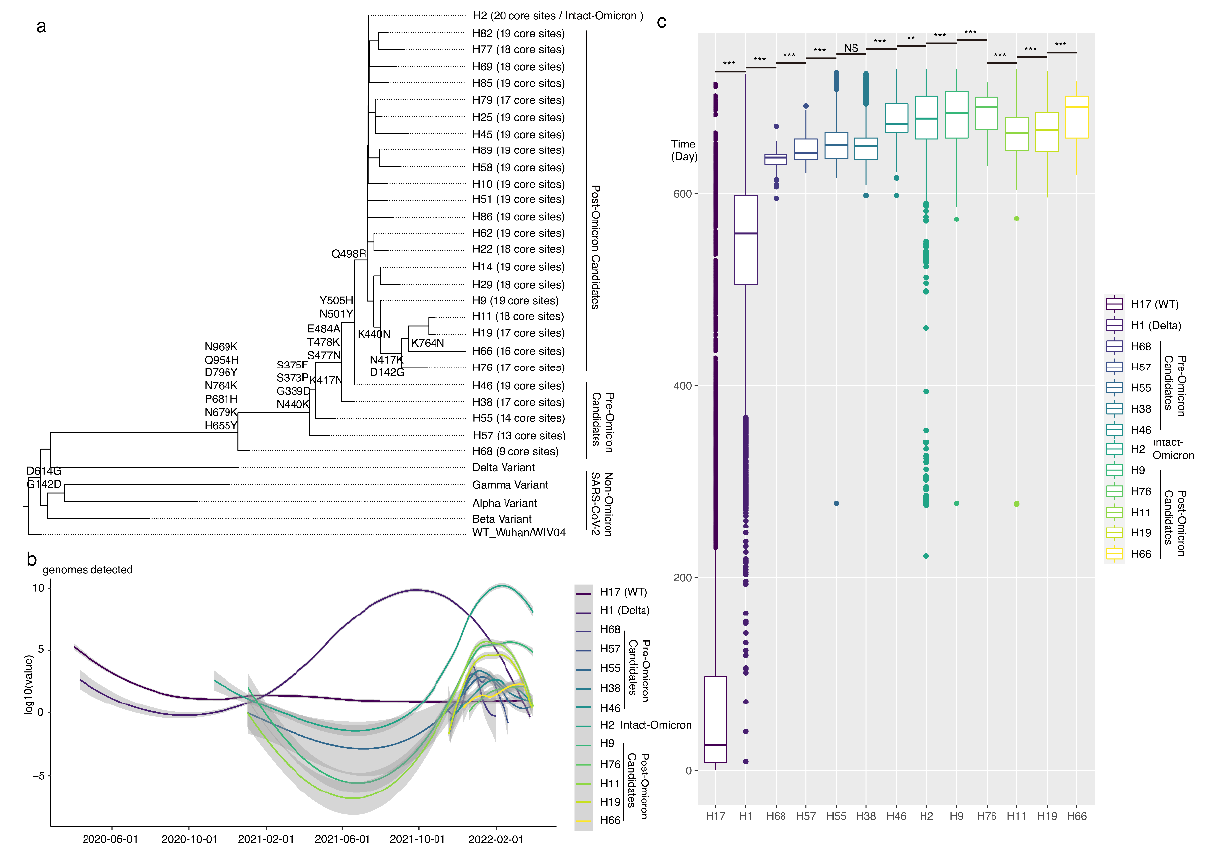
Figure 4. The evolutionary history and timeline of Omicron haplotypes. ( a ) Phylogenetic tree of Omicron haplotypes. Whole genomes of representative sequences of Omicron haplotypes were applied for tree construction. Tip labels are haplotype names of Omicron. The wild-type, Alpha, Beta, Gamma, and Delta variants are regarded as outgroups. The core mutations and major reverses in the spike of Omicron are labeled on branch nodes. ( b ) The detected number of SARS-CoV-2 genomes in each haplotype. The x-axis is the collected date; the y-axis is the log transferred genome number. Line shapes are loess smoothed. ( c ) Box plots show the collection time of all detected genomes in each haplotype. The x-axis is haplotypes; the y-axis shows the days between the collection time and 2020/04/01. The lines in the boxes are median values. T tests between haplotypes are marked with ***( p < 0.001), **( p < 0.01), *( p < 0.05), and NS (not significant).